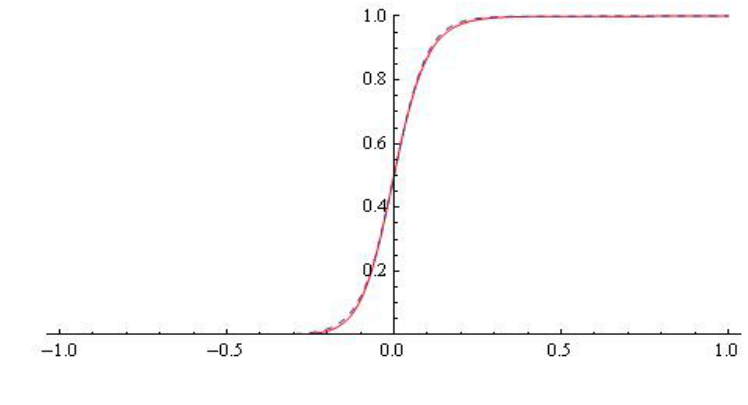
Fig. 3. Comparison between function V ( t ) (dashed) and N ( t ) (red) at fixed k = 20 and β = 21